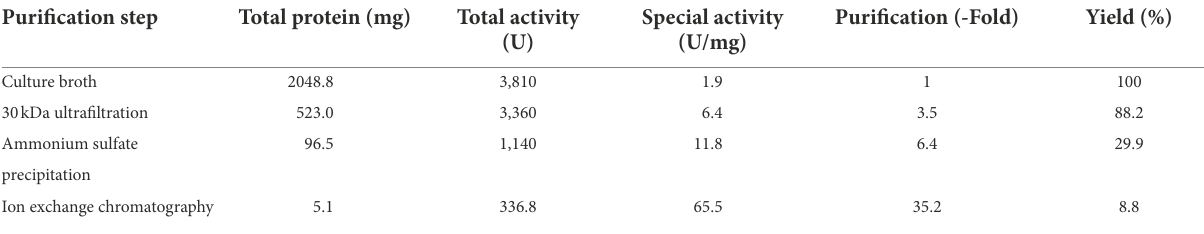
TABLE 1 Parameters related to purification of the dextranase